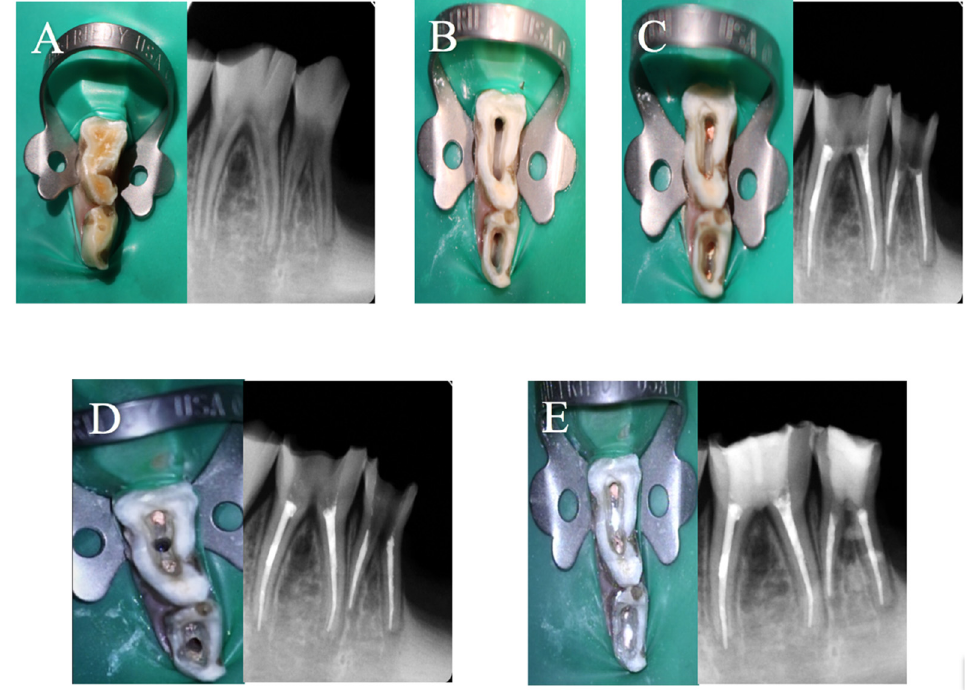
Figure 2. Clinical photographs and radiographic images of ( A ) pre-operative, ( B ) access opening, ( C ) obturation, ( D ) furcation induction, ( E ) perforation repair.